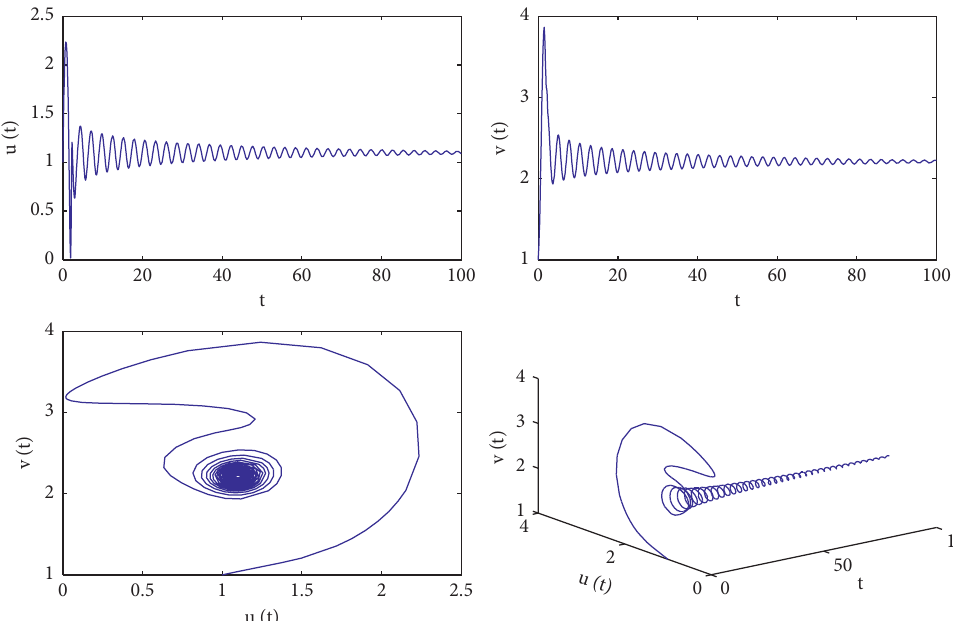
Figure 6: The trajectories graphs and phase graphs of system (94) with τ ( 1 , 1 ) .